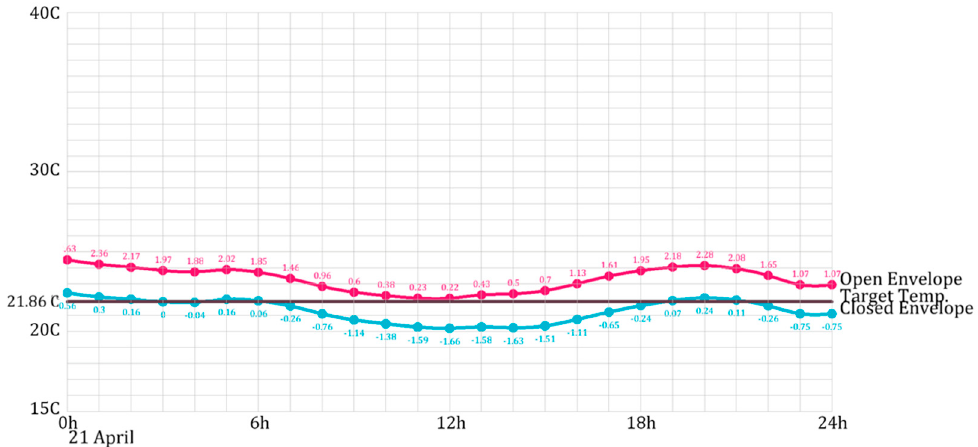
Figure 2. Temperature graph of 21 April showing thermal deviations from the calculated adaptive comfort temperature and generalized target temperature model in response to the operable element’s composition. Graph y-axis includes temperatures from 15–40 degrees Celsius. Graph x-axis includes hours of the specific day, from 0–24 h.